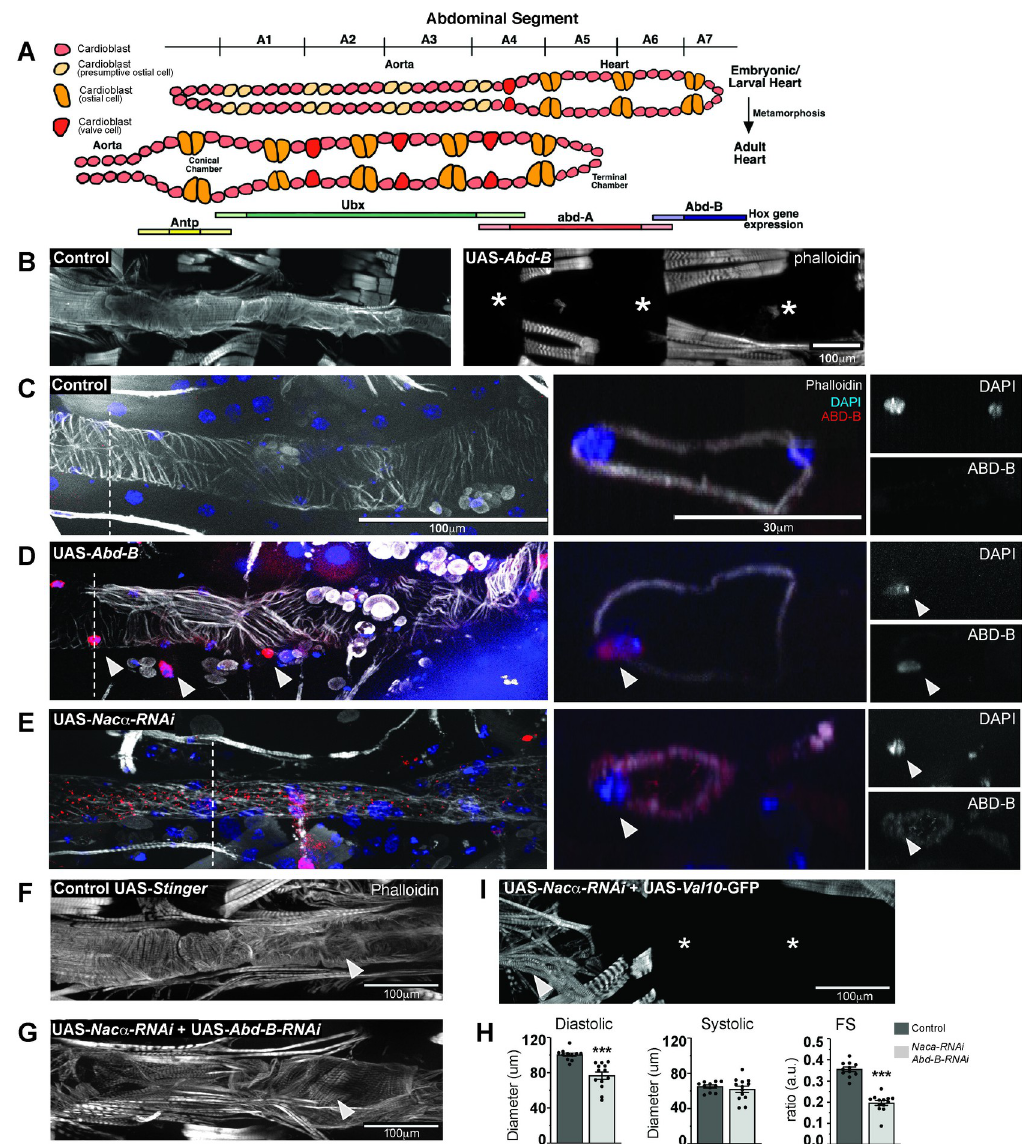
Fig 3. Nac α and the Hox gene Abdominal B ( Abd-B ) genetically interact in the heart. A, The embryonic/larval fly heart remodels into adult structures through trans-differentiation of the Ubx and abd-A expressing cardiomyocytes into the adult heart and terminal chamber, respectively. The cardiomyocytes of the posterior larval heart that express Abd-B (abdominal segment 6–7) histolyze and are absent in the adult heart. B, Overexpression of Abd-B in the heart using the cardiac driver Hand4 . 2 -GAL4 led to complete absence of the adult heart, which in early stages of pupation was still present (see D ). � indicates absence of the heart tube. C-E. Immunohistochemistry of pupal hearts 26–28 hours After Puparium Formation (APF). Dashed lines mark the region of the heart where orthogonal cross-sections were taken to examine Abd-B and DAPI expression in the nuclei. Images of the cross-section of cardiomyocytes and nuclei are displayed in the right panel. Arrowheads indicate either cardiac and pericardial nuclei that are both ABD-B and DAPI positive. C, In controls, phalloidin stained the circumferential fibers of the pupal aorta and heart. ABD-B staining was not detected in the cardiomyocyte nuclei within aorta and anterior heart segments but, ABD-B is stained in the posterior segments of the embryo. D, Overexpression of Abd-B using Hand4 . 2 - GAL4 resulted in strong ABD-B staining in the nuclei (as indicated by the arrowheads) throughout the pupal heart and pericardial cells prior to remodeling. Cross section clearly shows that ABD-B is localized in the nucleus. E, Knockdown of Nac α in the heart resulted in ectopic ABD-B expression throughout the heart tube. Staining was present within the nuclei (marked by DAPI), cytoplasm and heart lumen (see orthogonal sections, right). F-H. Concurrent knockdown of Nac α and Abd-B in the heart, G , led to rescue of heart tube formation, with visible circumferential fibers (arrowheads) albeit less well-organized than controls. H, Rescued hearts were smaller in diastolic diameter with no change in systolic diameter resulting in reduced Fractional Shortening (FS). This effect was not due to titration of GAL4 onto 2 UAS sites, as combination of UAS- Nac α